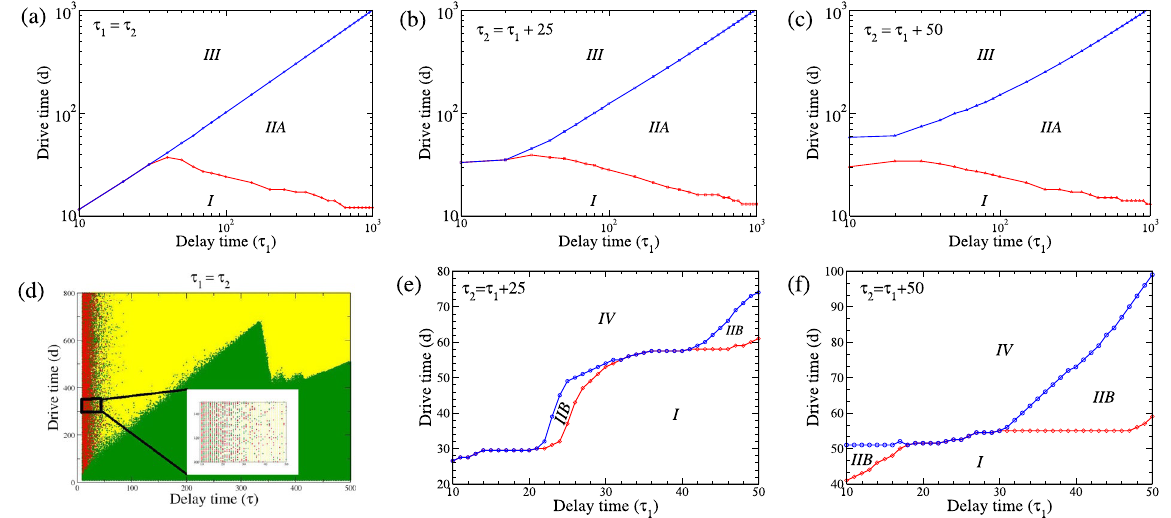
Figure 4. Phase space in the drive time ( d ) vs. the delay time ( τ 1 ) plane for ( a ) Regime A: τ 2 = τ 1 ; ( b ) Regime A: τ 2 = τ 1 + 25; ( c ) Regime A: τ 2 = τ 1 + 50; ( d ) Regime B: τ 2 = τ 1 . The inset shows a magnified view of a small region of this phase space to illustrate the chaotic behaviour in this regime; ( e ) Regime B: τ 2 = τ 1 + 25; ( f ) Regime B: τ 2 = τ 1 + 50. All other parameters for regime A and regime B are as defined in the